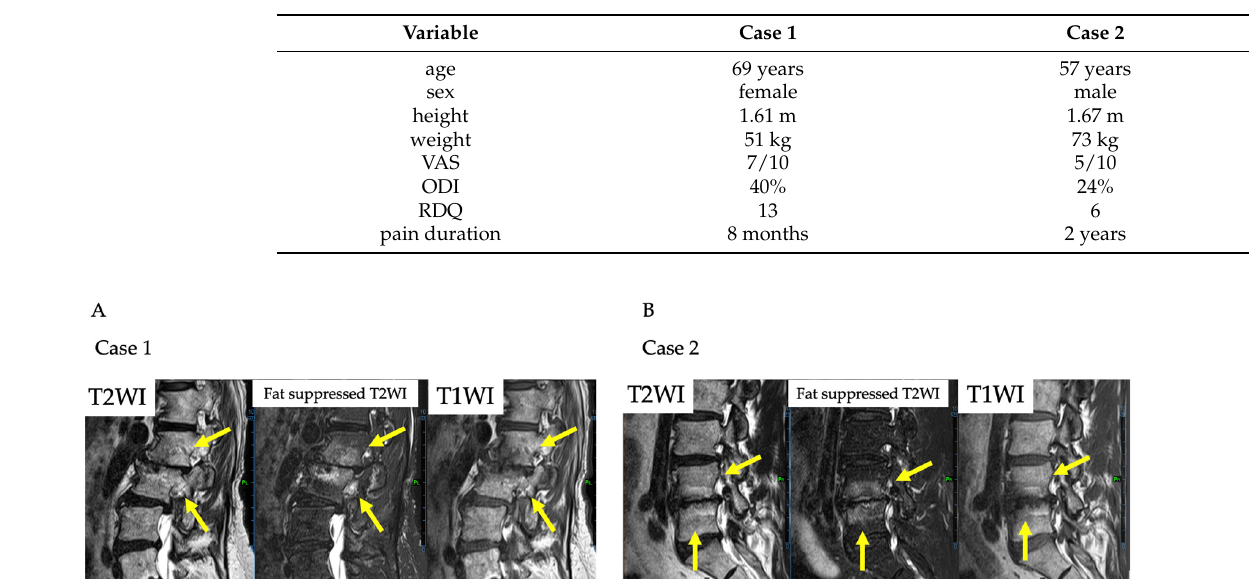
Figure 3. MRI images before PRP administration for case 1 and case 2. ( A , B ) are MRI images before PRP administration for case 1 and case 2, respectively, showing Modic type 1 at L2/3 in case 1 and at L4/5 in case 2 (yellow arrows). Table 4. Laboratory data.